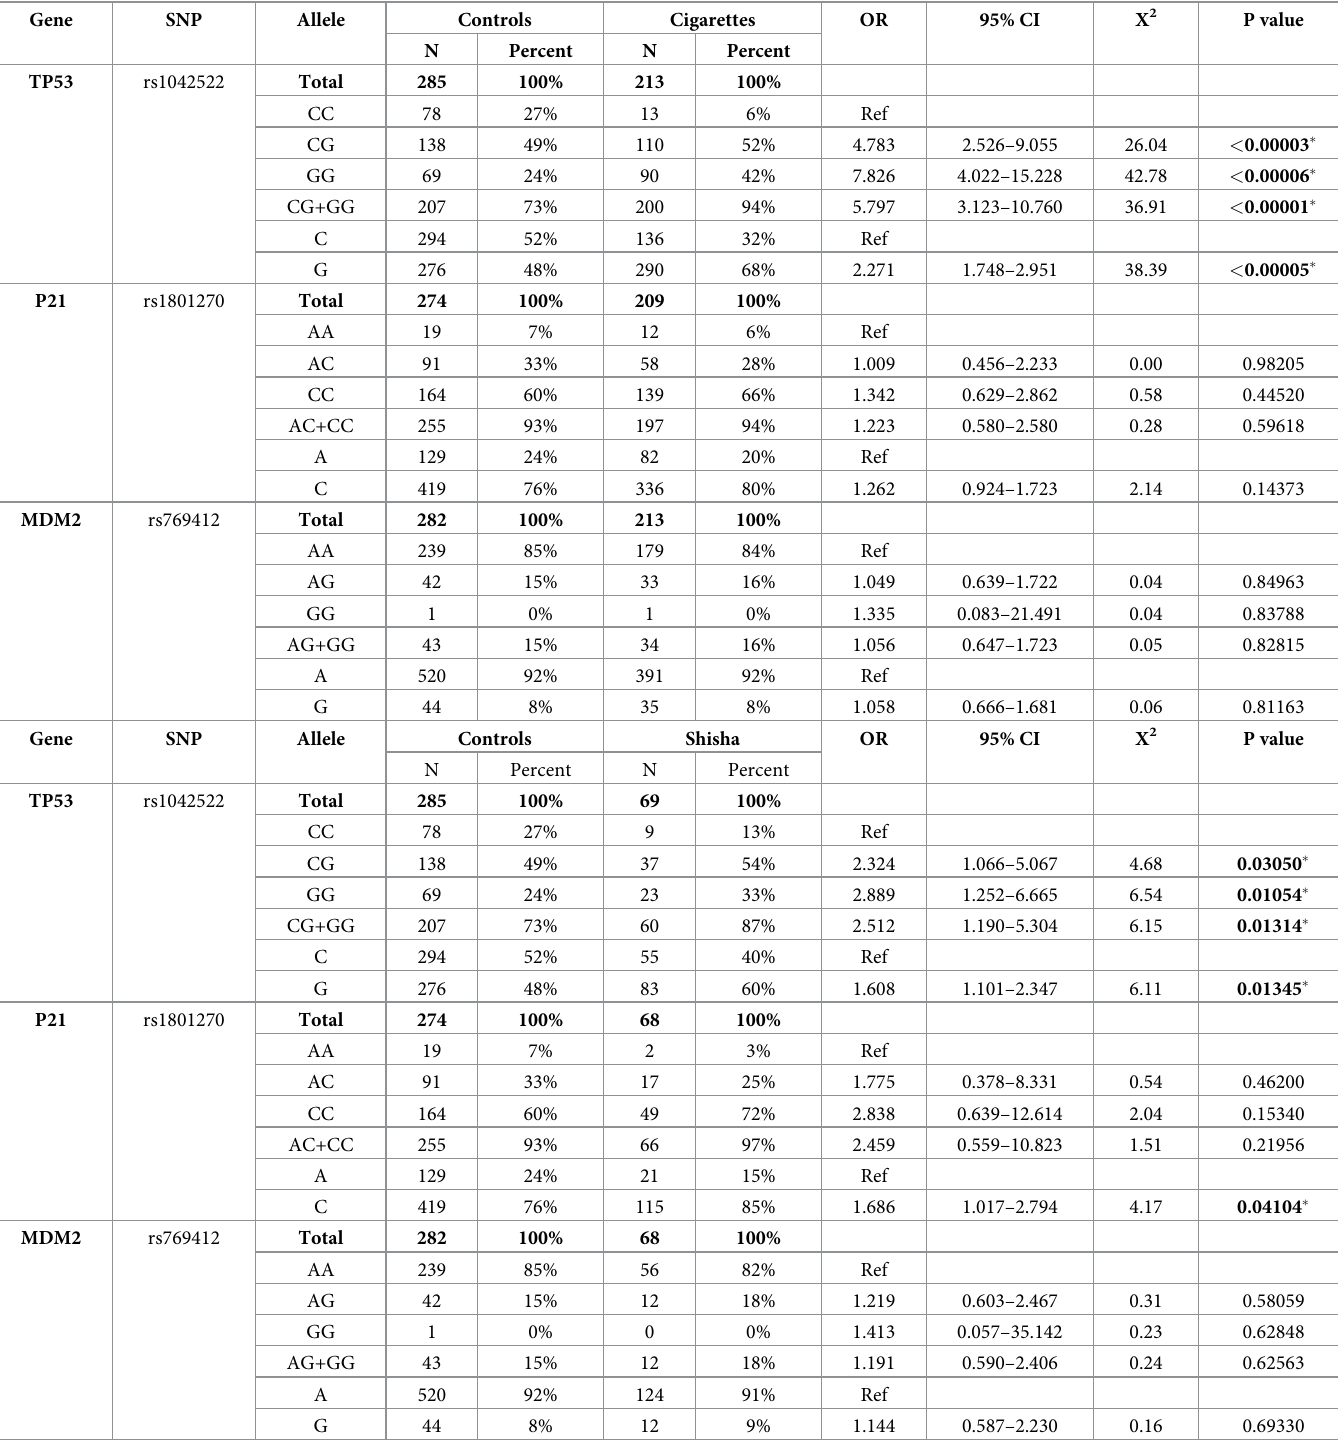
Table 7. Distribution of genotype frequencies of selected SNPs in P53, P21, and MDM2 genes in smokers smoking cigarettes and shisha. Gene SNP Allele TP53